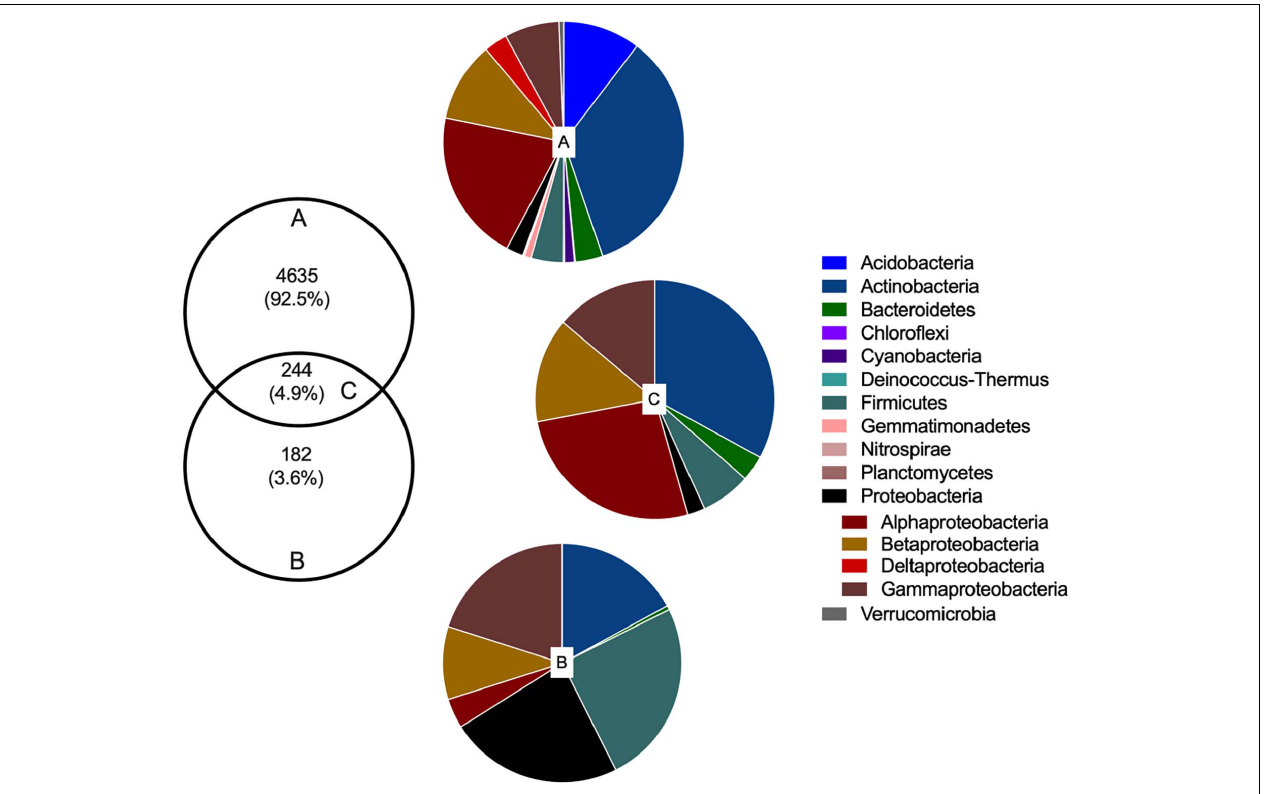
FIGURE 1 | Rhizobacterial taxonomic composition in culture-independent and -dependent communities of wheat grown in soils with and without fertilizer addition. Venn diagram showing the number and proportion of unique ASVs (at 97% similarity) in (A) culture-independent and (B) culture-dependent communities, and (C) shared ASVs detected with both methods. Pie charts correspond to the percentage of bacterial phyla and classes of Proteobacteria assigned to each